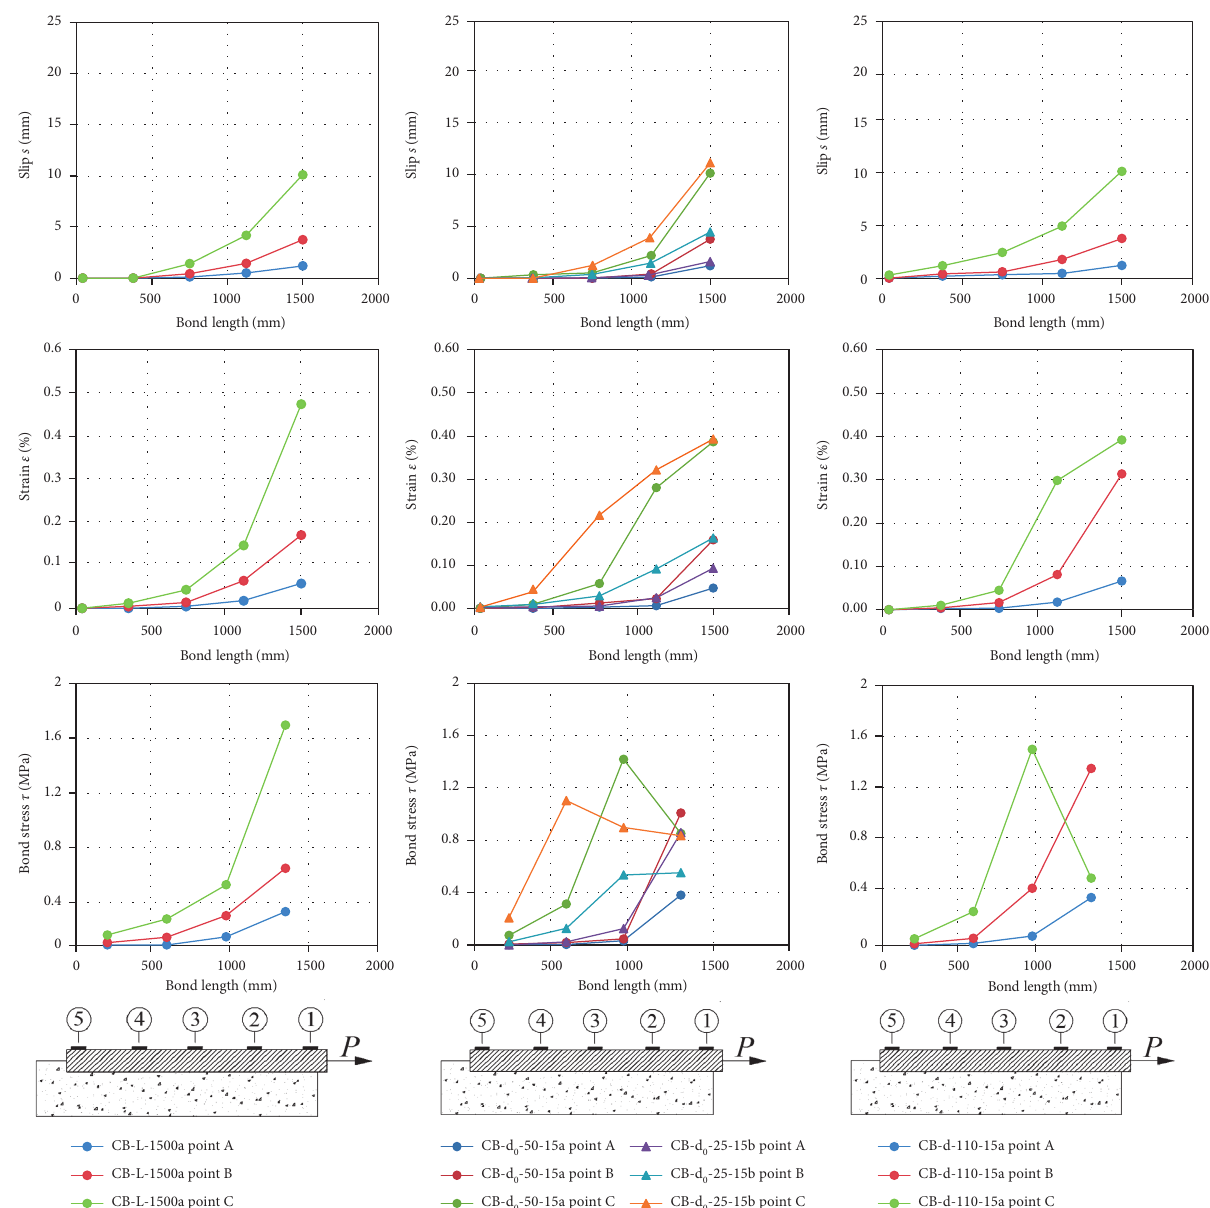
Figure 14: Stress, strain, and slip distribution of the bonding interface in the axial direction of the short bolt ( L < L